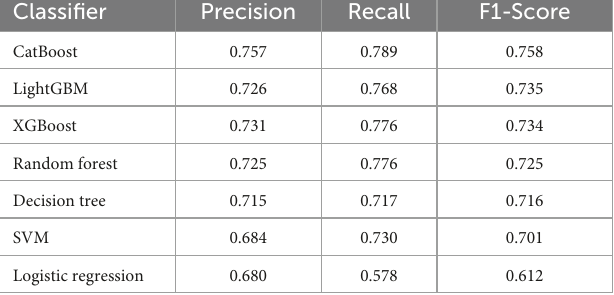
TABLE 3 Compare the performance of different ML algorithms to predict clients’ satisfaction with psychotherapy. Classifier